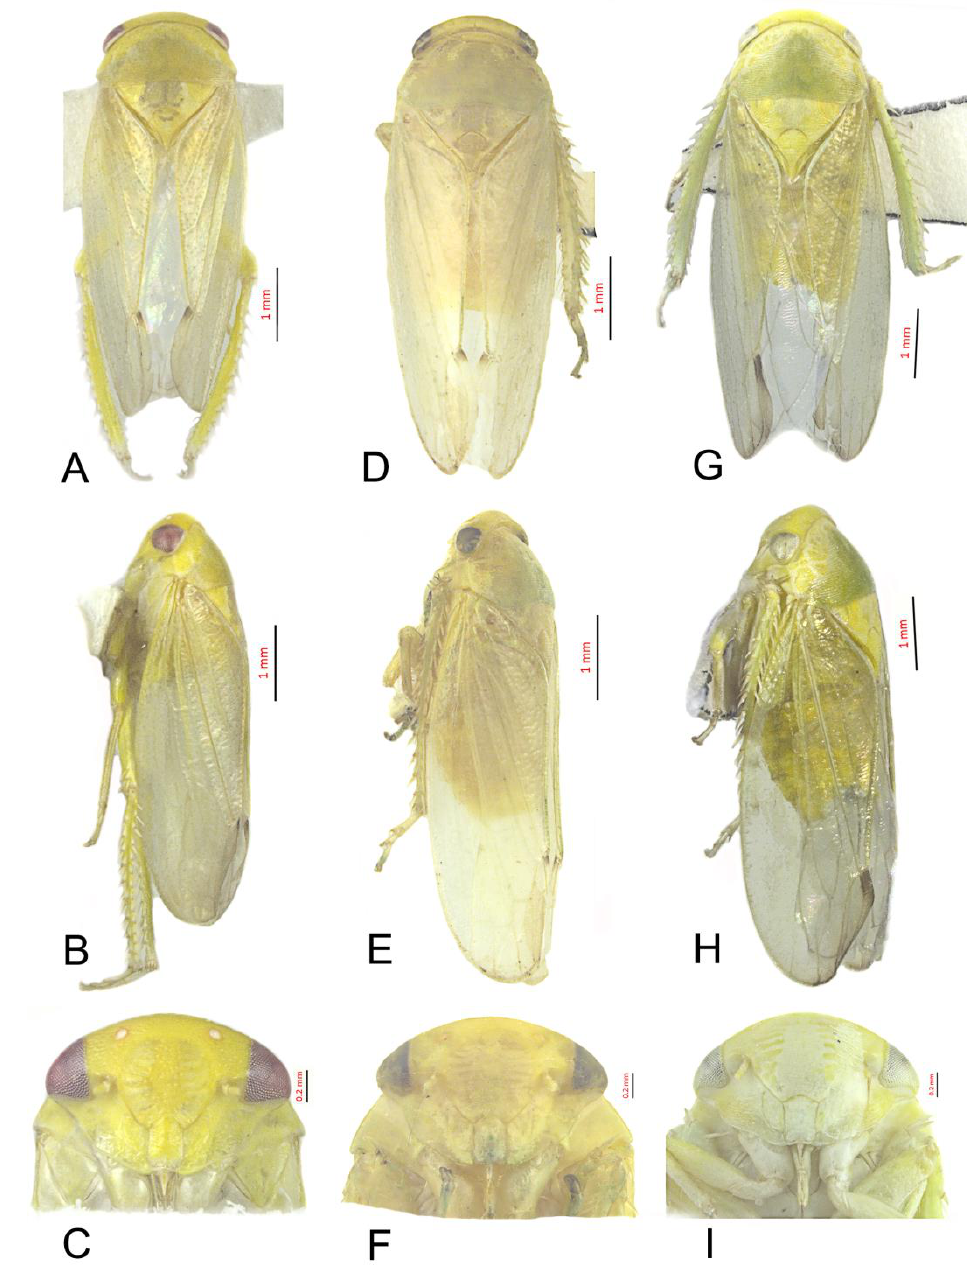
Figure 2. Batracomophus pandarus Knight, 1983: ( A ) habitus, ventral view, ( B ) habitus, lateral view, ( C ) face; Batracomorphus allionii (Turbon, 1802): ( D ) habitus, ventral view, ( E ) habitus, lateral view, ( F ) face; Batracomorphus subfuscus (Li and Wang, 1993): ( G ) habitus, ventral view, ( H ) habitus, lateral view, ( I ). face.